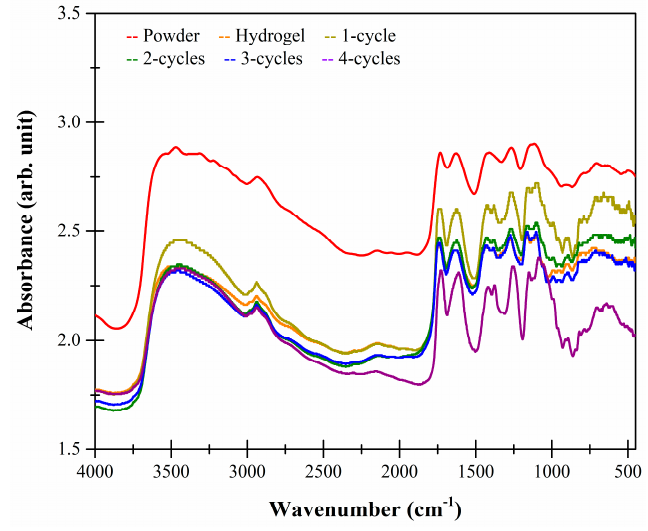
Figure 7 Figure 7. FTIR spectra of karaya powder, hydro- and